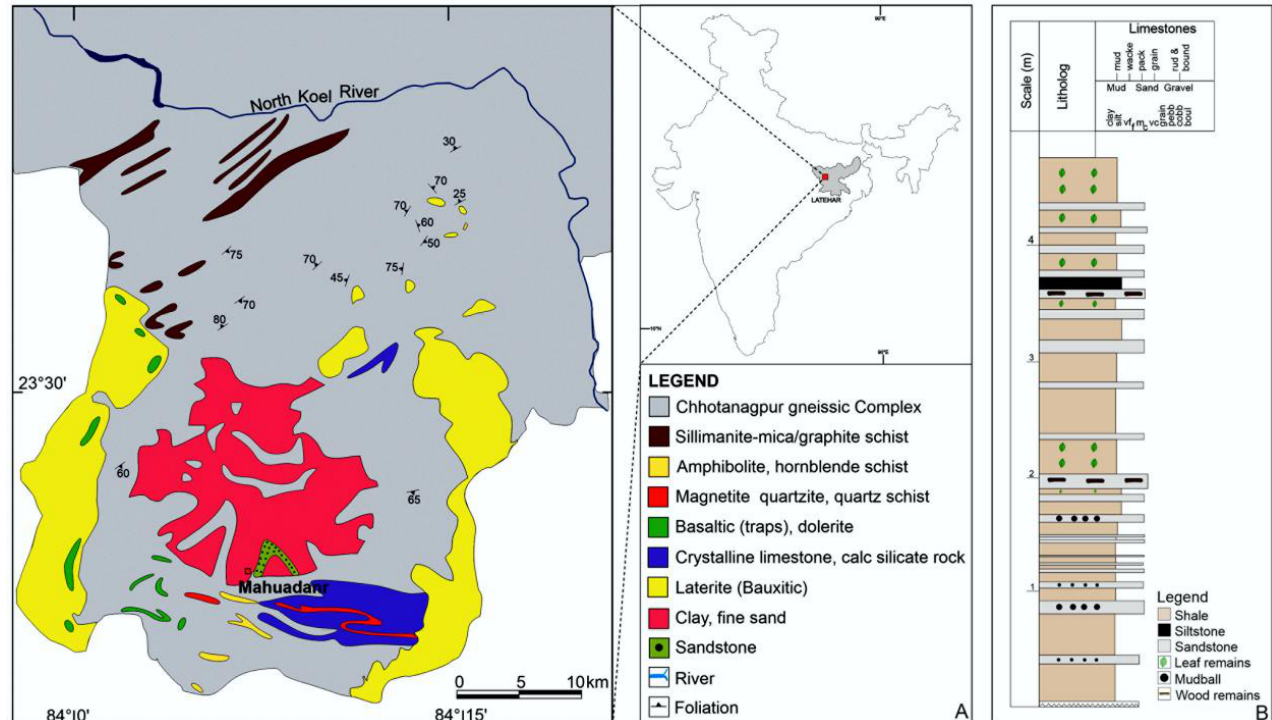
Figure 1. ( A ) Geological map of Mahuadanr and adjoining areas, Latehar District of Jharkhand (a part of the district resource map of Palamu district, Bihar published under the direction of Director General, Geological Survey of India, Kolkata); ( B ) sedimentological log of the section constructed using SedLog